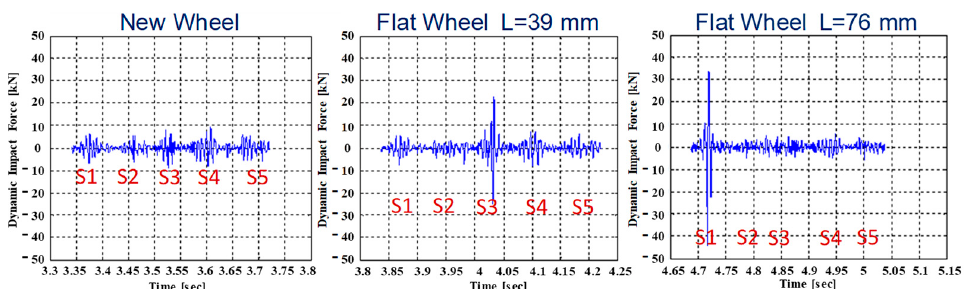
Figure 12. Dynamic impact force as a function of the defect length (for a train speed of 30 km/h). Similar results are reported in [123,127].